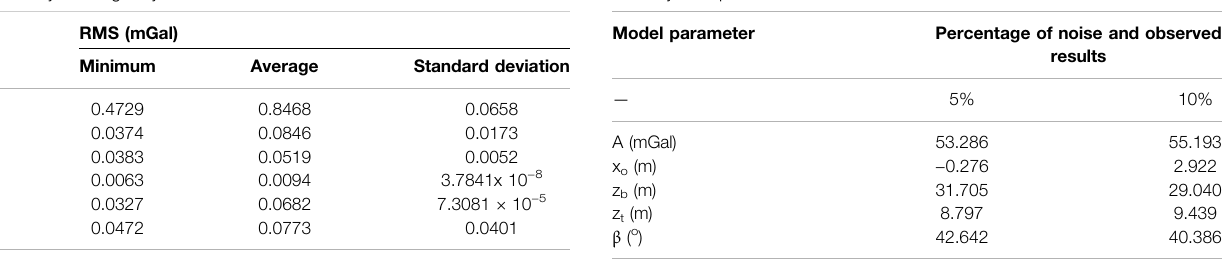
TABLE 4 | Statistical results for RMS values obtained from parameter tuning of MRFO for synthetic gravity dataset.